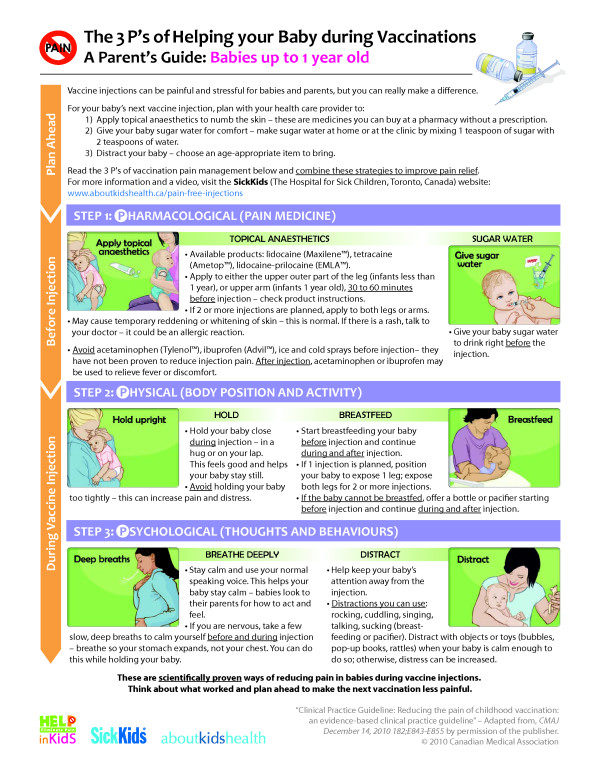
Final version of pamphlet.